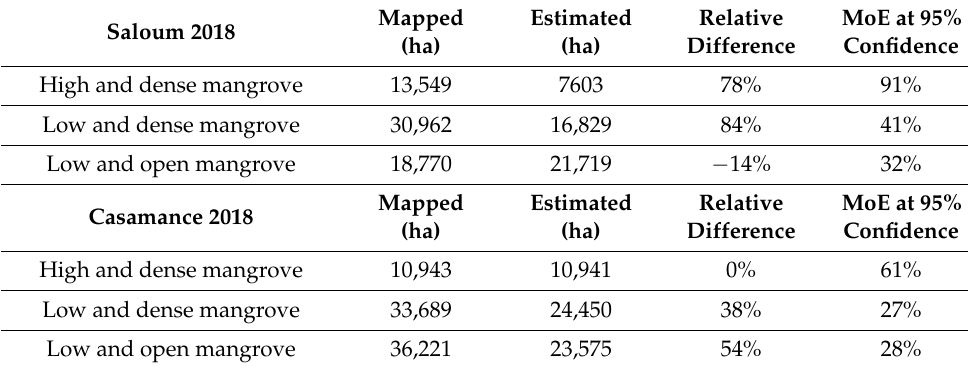
Table 6. Differences between the mapped areas and area estimates of the plant formation and relationship to the relative margin of error.